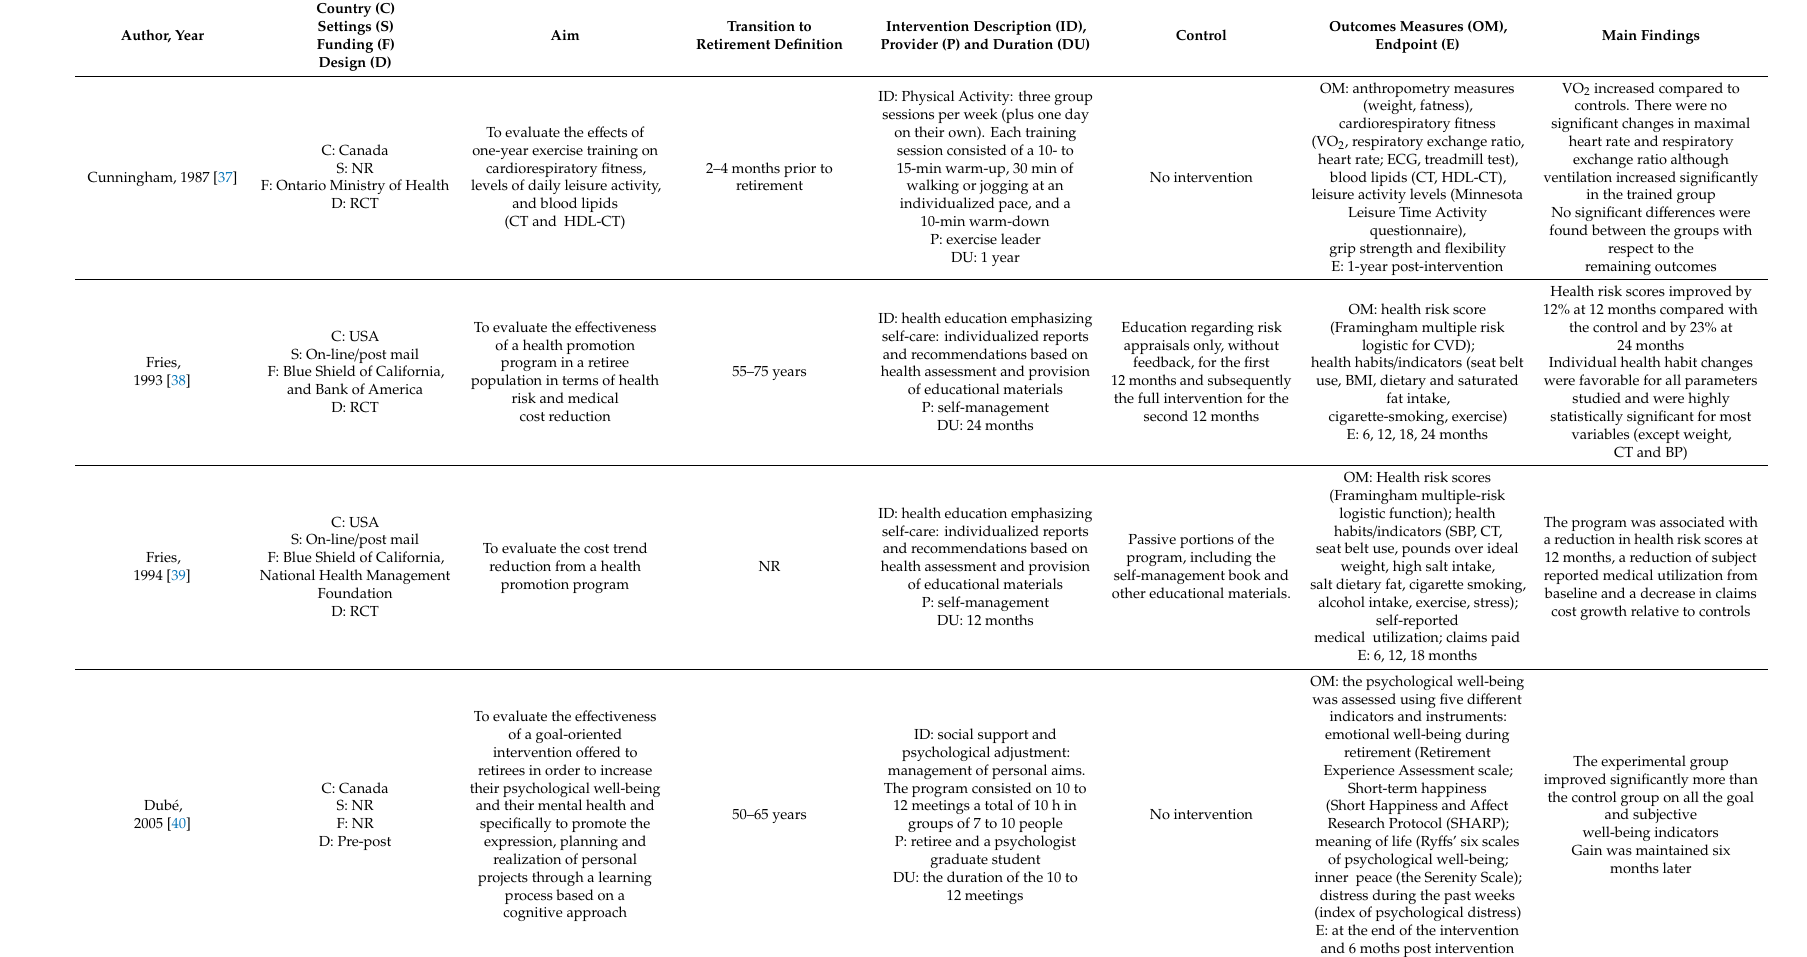
Table 2. Measures and main findings of experimental